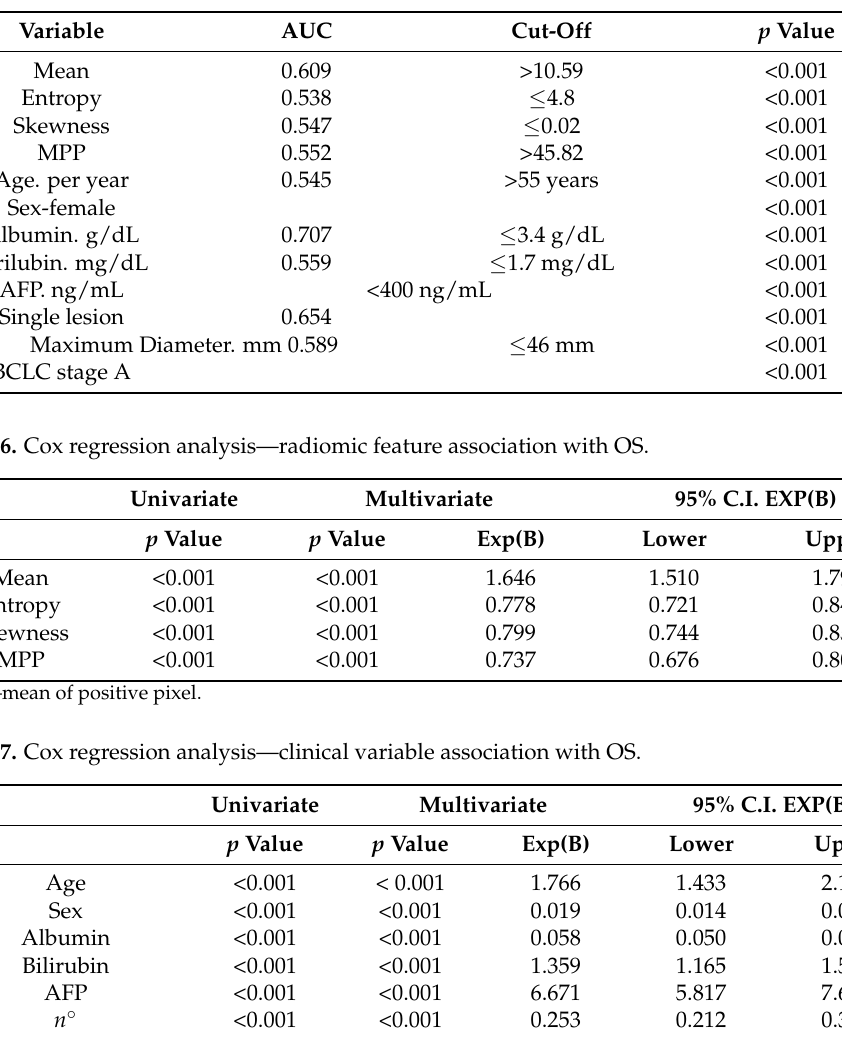
Table 5. Univariate analysis of radiomics and clinical variables for OS.